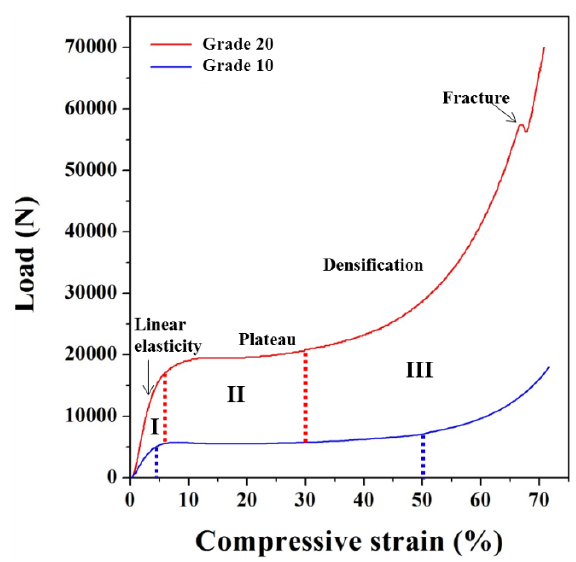
Figure 2. Compressive stress-strain curve of artificial bone.